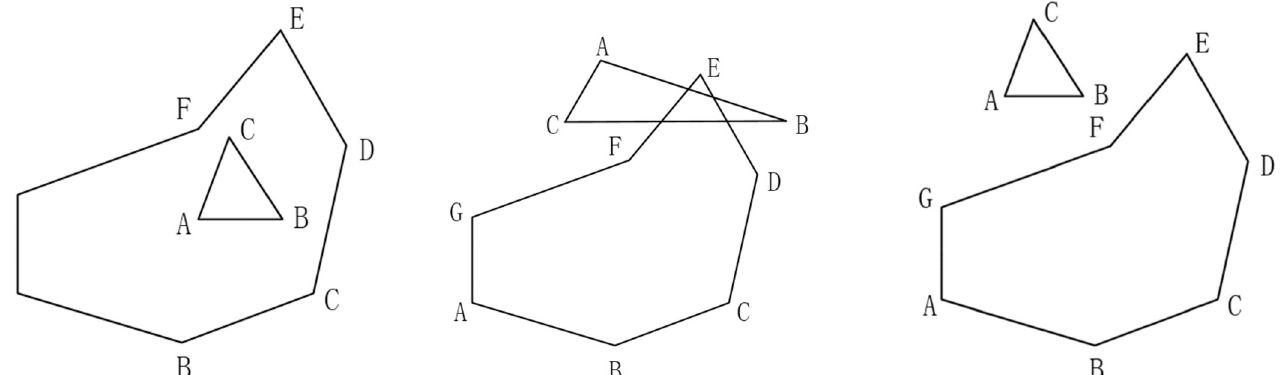
Fig 4. Location relationship of the triangle and the